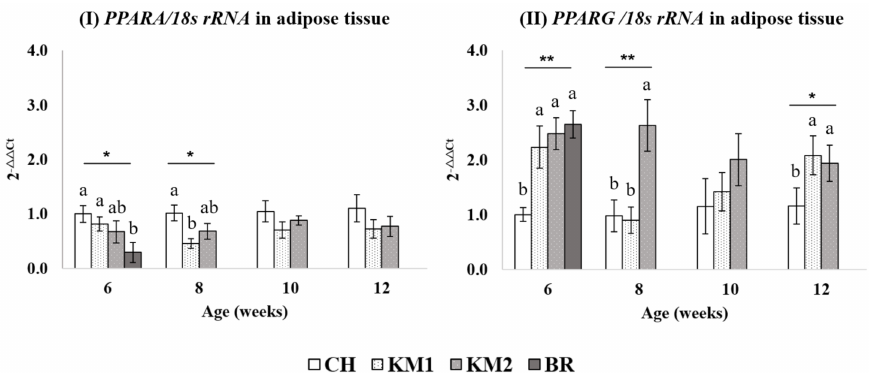
Figure 2. The transcriptional expression level of PPARA ( I ) and PPARG ( II ) normalized with 18S rRNA in abdominal fat tissue. a, b Mean values within a figure with no common letter differ significantly (* mean p < 0.05 and ** mean p < 0.01).